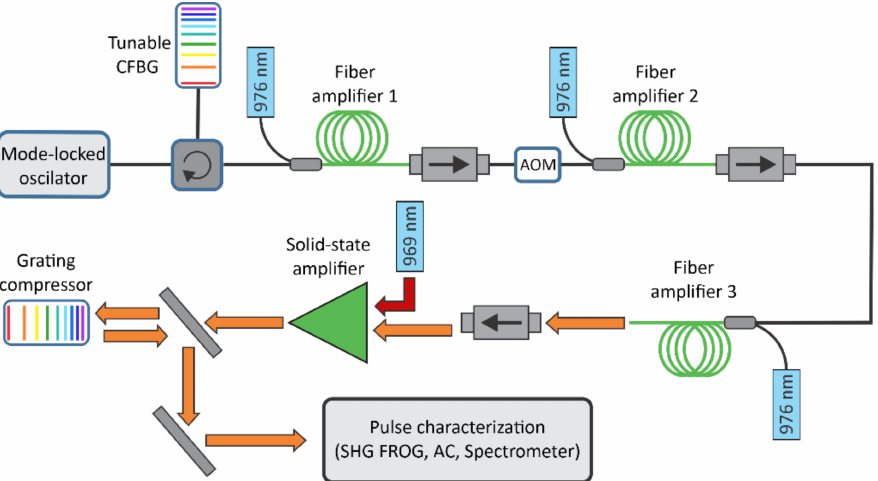
Figure 1. The experimental setup is based on a typical hybrid laser system consisting of a fiber pre-amplifier and an additional solid-state amplifier. The system comprises of femtosecond mode- locked laser, tunable pulse stretcher (CFBG), pulse picker (AOM), three fiber amplifiers, a solid- state amplifier and a grating compressor. The pulses from the laser system are then analyzed in a detailed pulse characterization setup consisting of a SHG FROG, a spectrum analyzer and an intensity